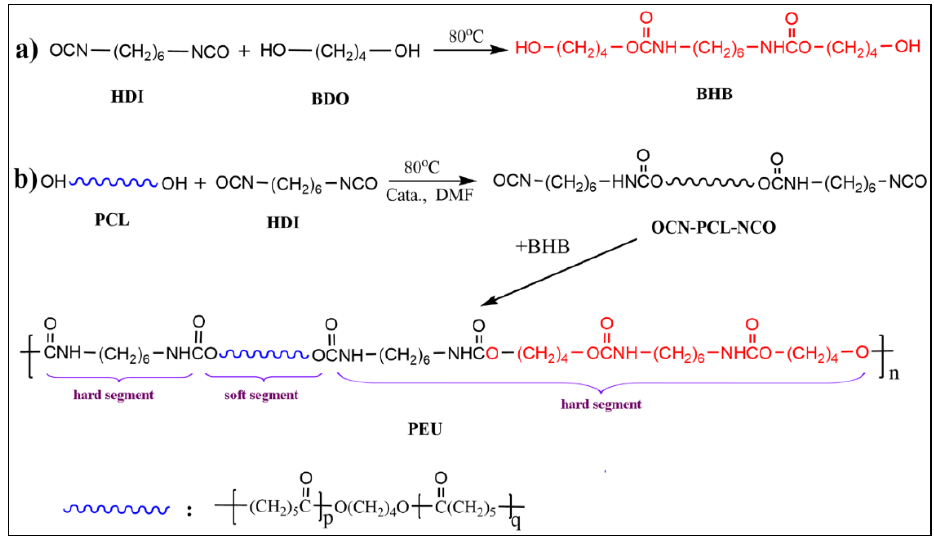
Figure 1. Synthetic ‐ pathways of ( a ) BHB and ( b ) PEU. Figure 1. Synthetic-pathways of ( a ) BHB and ( b )